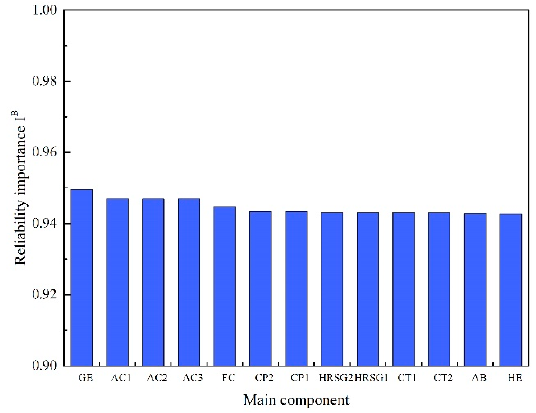
Figure 12. The BI values of the components of the CCHP system.